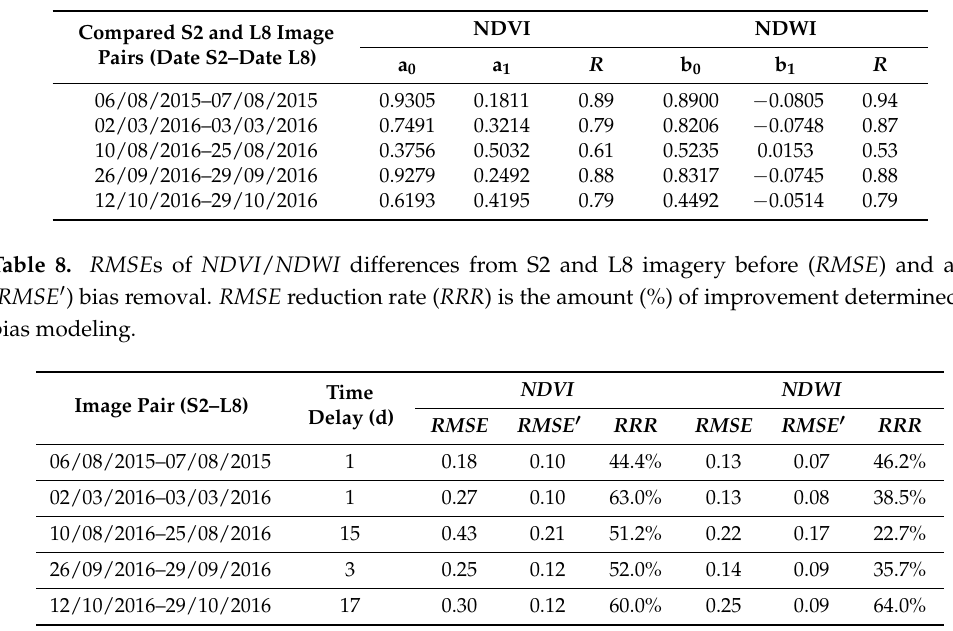
Table 7. Correlation coefficient ( R Pearson) and parameters of linear regression (see (8) and (9)) relating S2 and L8 NDVI / NDWI . Linear regressions were used to remove bias error between S2 and L8 derived spectral indices. All of the correlations are significant at p = 0.01.